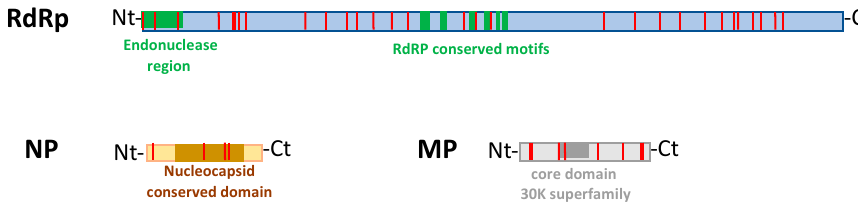
Figure 3. Position of amino acid signatures specific to CCGaV isolates infecting citrus and apple hosts (in red) identified in RdRp, NP and MP proteins. Conserved domains in each protein are indicated with different